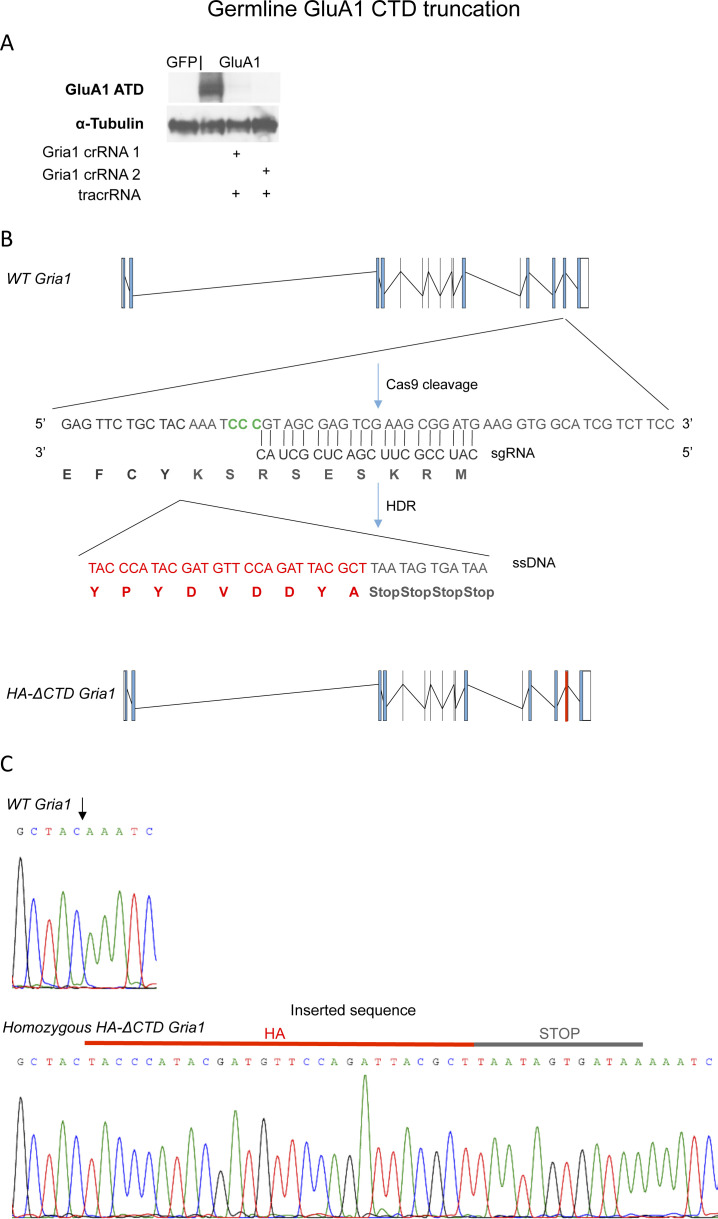
Generation of the HA-ΔCTD GluA1 KI mouse line.(A) 2 crRNAs where tested to generate the KI mice. Both of them were able to disrupt the expression of overexpressed GluA1 in 293 T cells, so half of the oocytes were injected with each of them. Tested in two biological replicates and several technical replicates. (B) Overview of the strategy to generate the HA-ΔCTD GluA1 allele. The sequence recognized by the Gria1 gRNA 1 (CAUCGCUCAGCUUCGCCUAC) is indicated. Also indicated is the sequence of the ssDNA co-injected to serve as a template for HDR 3’ of the 4 initial amino acids (EFCY) after the last TM helix in the Gria1 gene, which encodes the influenza haemagglutinin (HA) tag sequence followed by four Stop codons to ensure truncation of the remainder CTD of the protein, flanked by 60 nt-long 5’ and 3’ homology arms. (C) Sequencing of Gria1 in homozygous WT (top chromatogram) and HA-ΔCTD GluA1 (bottom chromatogram). The HA-tandem stop codon insertion site is indicated with an arrow.